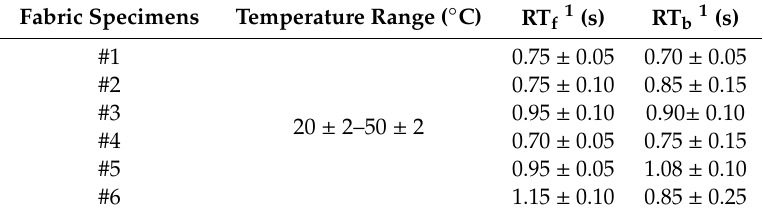
Figure 10. Microscopic images(X12) of all the samples of the fabric temperature sensors from No.#1( a ) to No.#6 ( f ) with front and back sides. Table 5. Response time of the fabric temperature sensors in oil bath with two